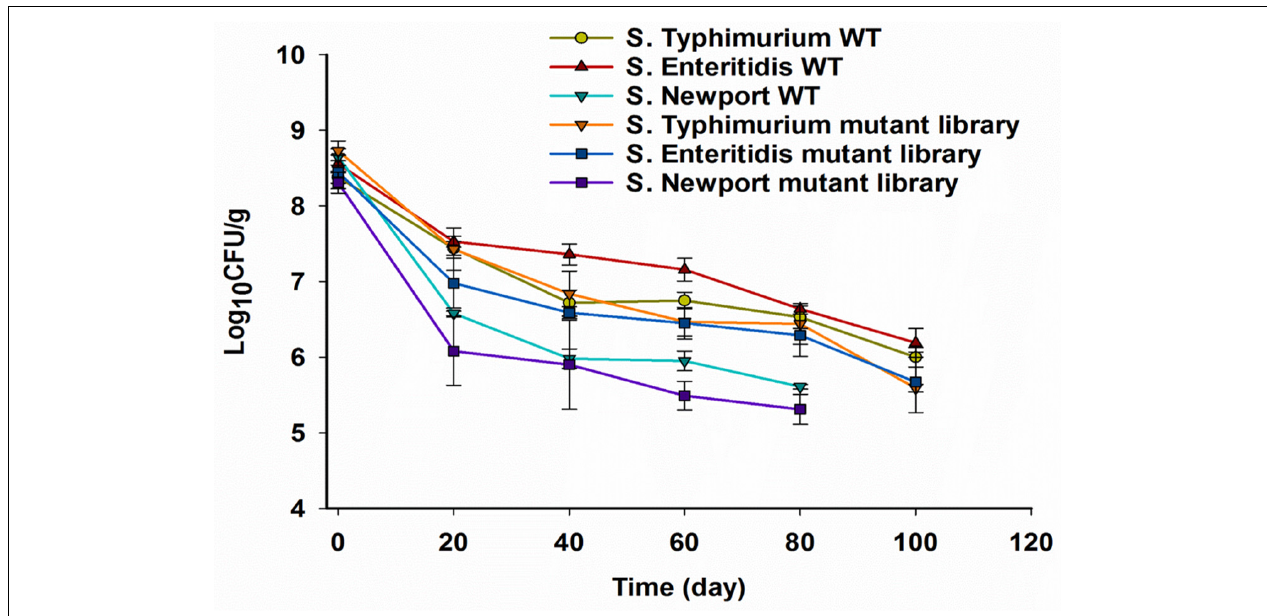
FIGURE 1 | Survival of Salmonella wild-type (WT) strains and Tn 5 mutant libraries on in-shell pistachios. Pistachios were inoculated, dried and stored, and populations of Salmonella were enumerated as described in section “Materials and Methods” immediately after inoculation, after drying, and periodically during storage. Data represent averages from three independent trials with duplicate samples per trial. Error bars indicate standard deviation ( n = 6). Enumerations of S. Newport C4.2 on pistachios were discontinued when the population was less than 6 log